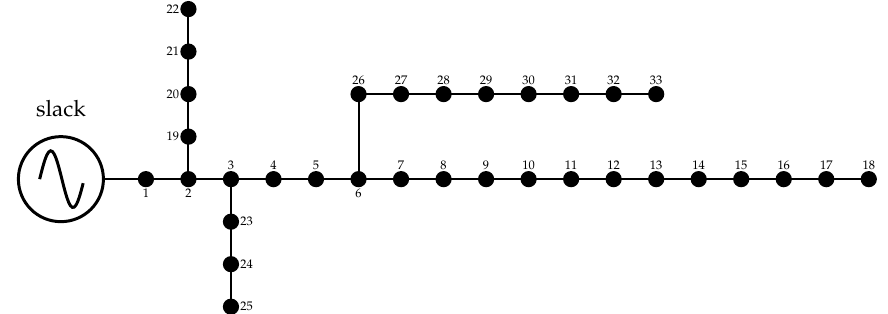
Figure 5. Electrical configuration of the 33-node test